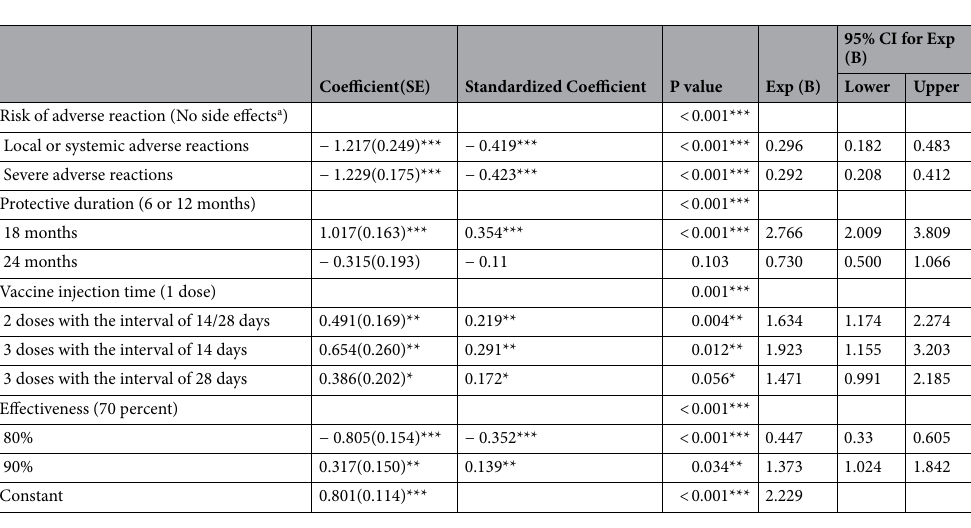
Table 2. Regression results of vaccination preferences on different attributes and levels. *p < 0.1. **p < 0.05. ***p < 0.001. a The levels in brackets after each variable (i.e. risk of adverse reaction, protective duration, vaccine injection time, and effectiveness) in Table 2 were reference